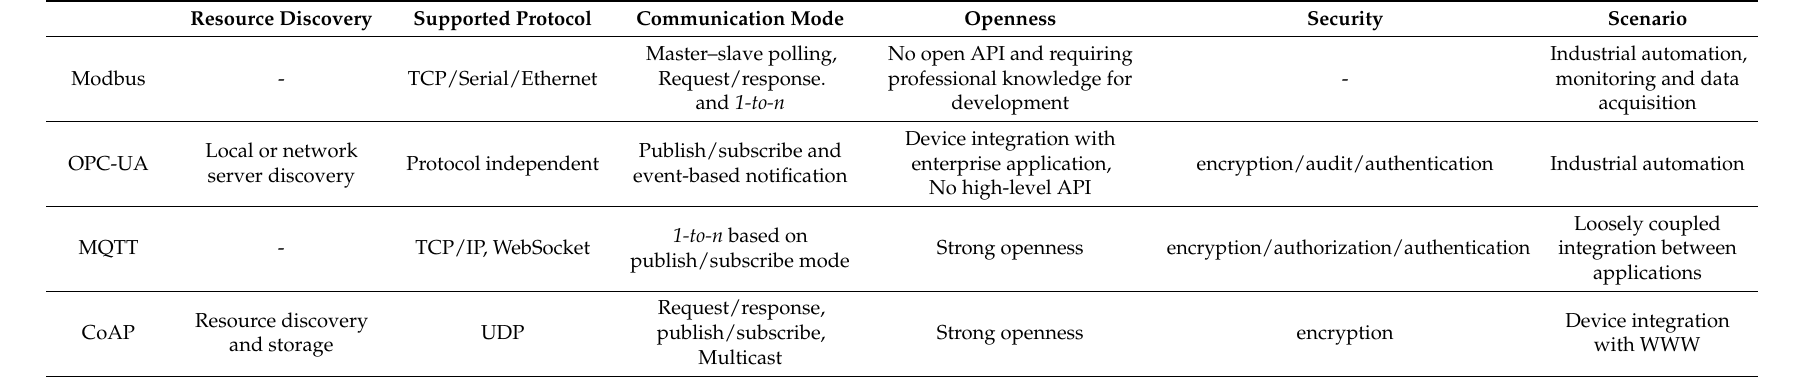
Table 2. Comparison of IoT application layer